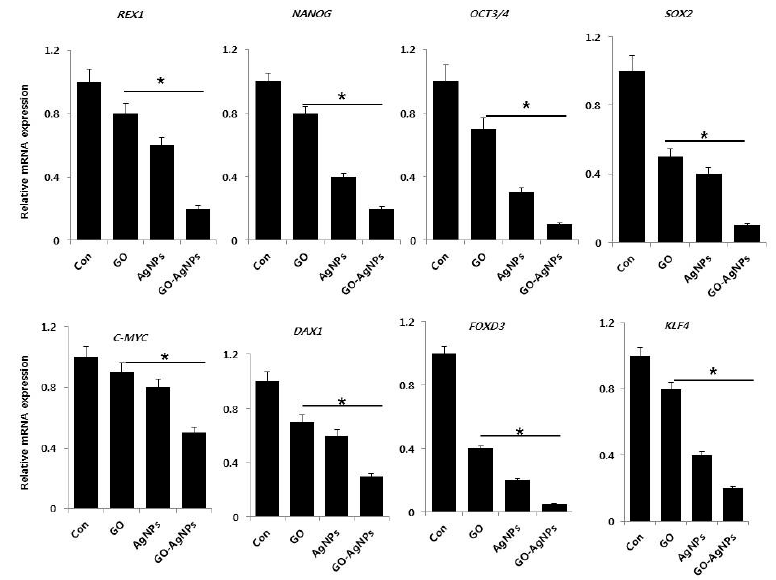
Figure 6. Reverse transcription-quantitative polymerase chain reaction (RT-qPCR) analysis of expression of various stem cell markers. The expression pattern of various stem cell markers genes were analyzed by exposure of SH-SY5Y cells to GO (10 µg/mL), AgNPs (5 µg/mL) and GO-AgNPs